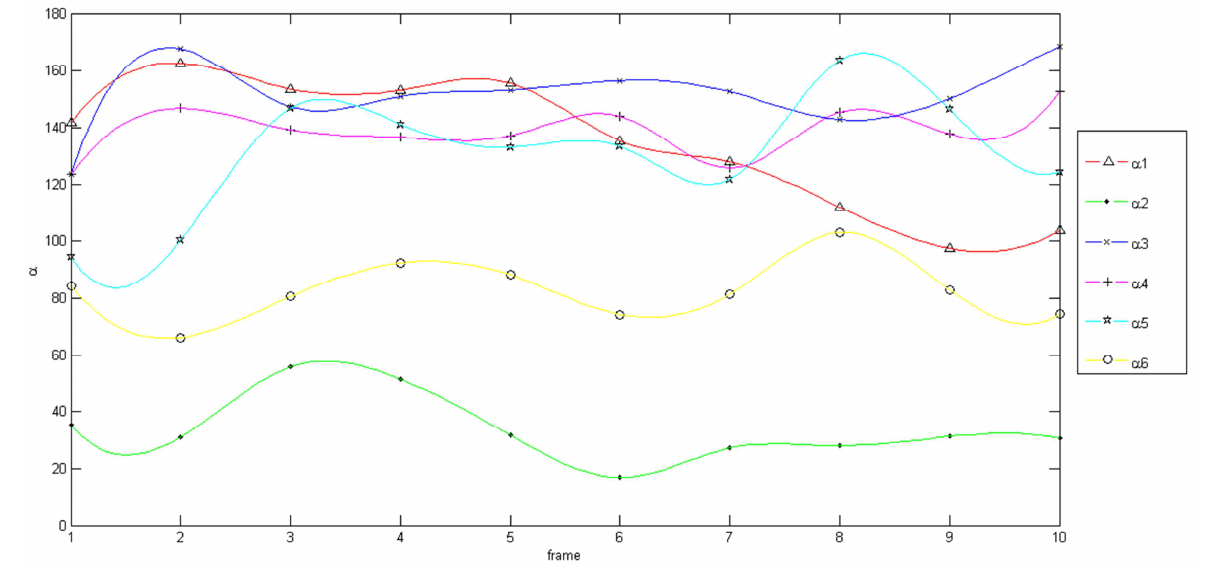
Figure 7. Angle positions on the selected successive frames After the pixel coordinates of the targets were determined from the intensity images, their 3-D coordinates were extracted from the image files (Table 2). The 6 angles between the 7 lines were computed from selected frames by Eq.4 in 3-D space (Figure 7,